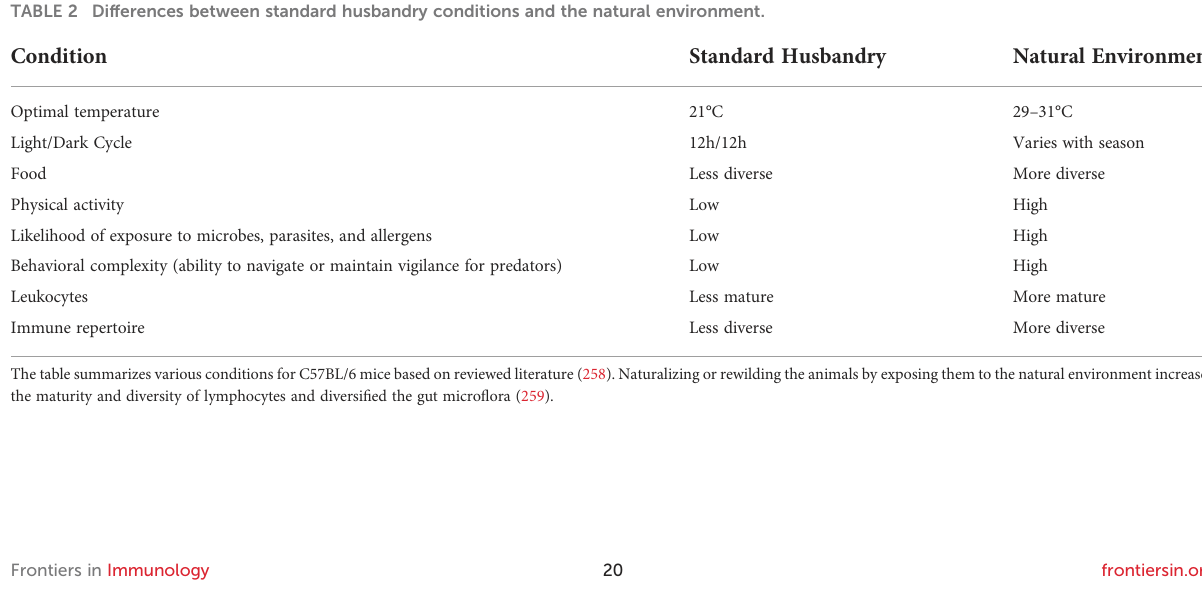
TABLE 2 Differences between standard husbandry conditions and the natural